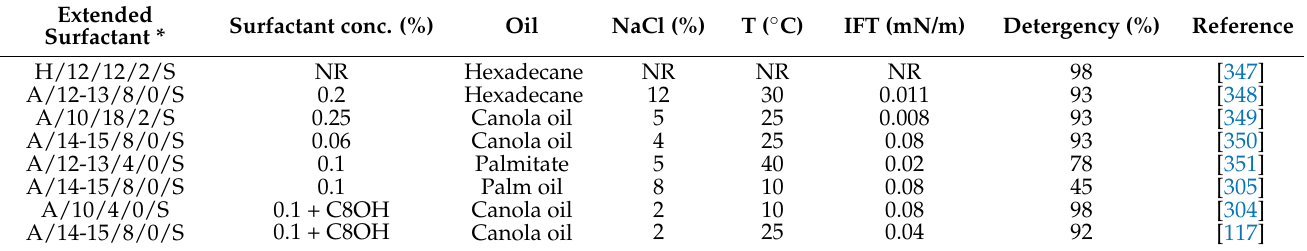
Table 4. Detergency studies using extended surfactants. Surfactant concentration, type of oil removed, temperature, interfacial tension at optimum, and detergency % are